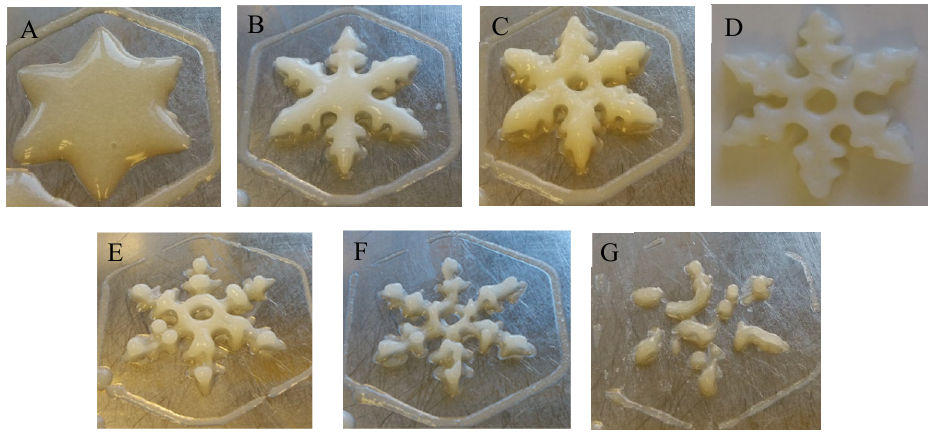
Figure 5. Different geometrical shapes of the selected 3D printing formulation samples with different viscosities. ( A ) 0.483 Pa · s (Test 1), ( B ) 0.587 Pa · s (Test 2), ( C ) 0.753 Pa · s (Test 19), ( D ) 1.374 Pa · s (Test OF, the optimum formulation), ( E ) 1.814 Pa · s (Test 22), ( F ) 1.885 Pa · s (Test 11), ( G ) 2.058 Pa · s (Test 24). The extrusion parameters were as follows: nozzle diameter of 1.0 mm, nozzle height of 3.0 mm, nozzle moving speed of 70 mm/s, and extrusion rate of 0.004 cm 3 /s.